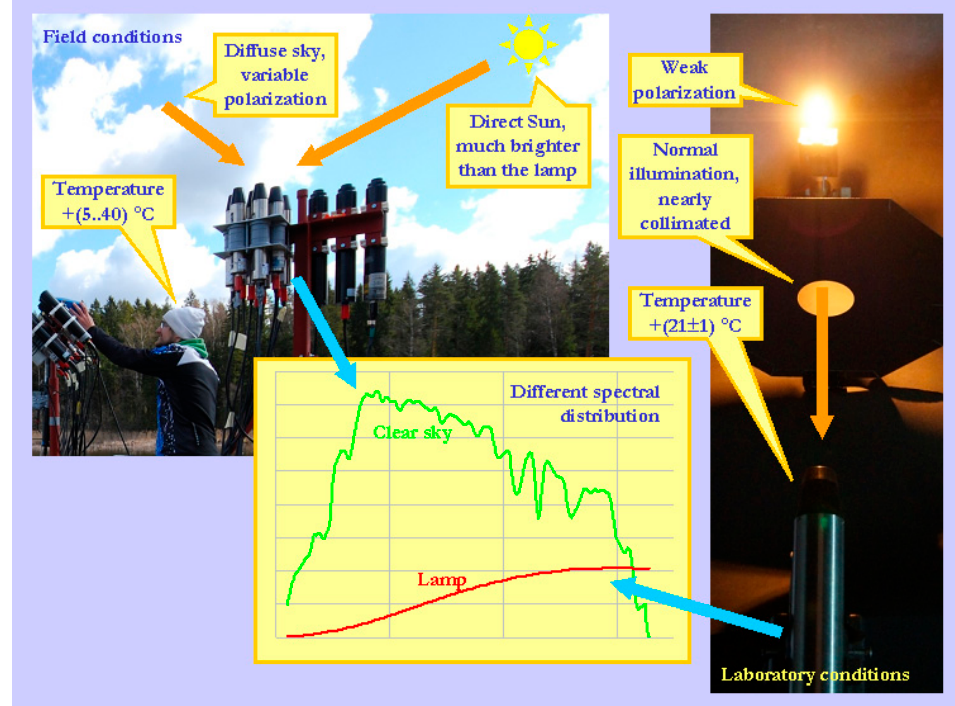
Figure 1. Main differences between the field and laboratory measurements of the second laboratory comparison exercise (LCE-2) causing a substantial increase in uncertainty of the field measurements.